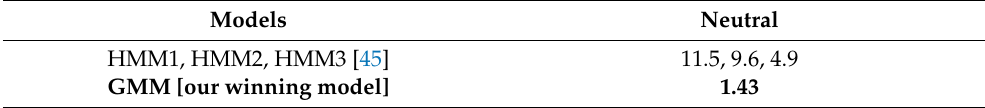
Table 8. Equal error rates (%) for the GMM and different classifiers for the Emirati database.